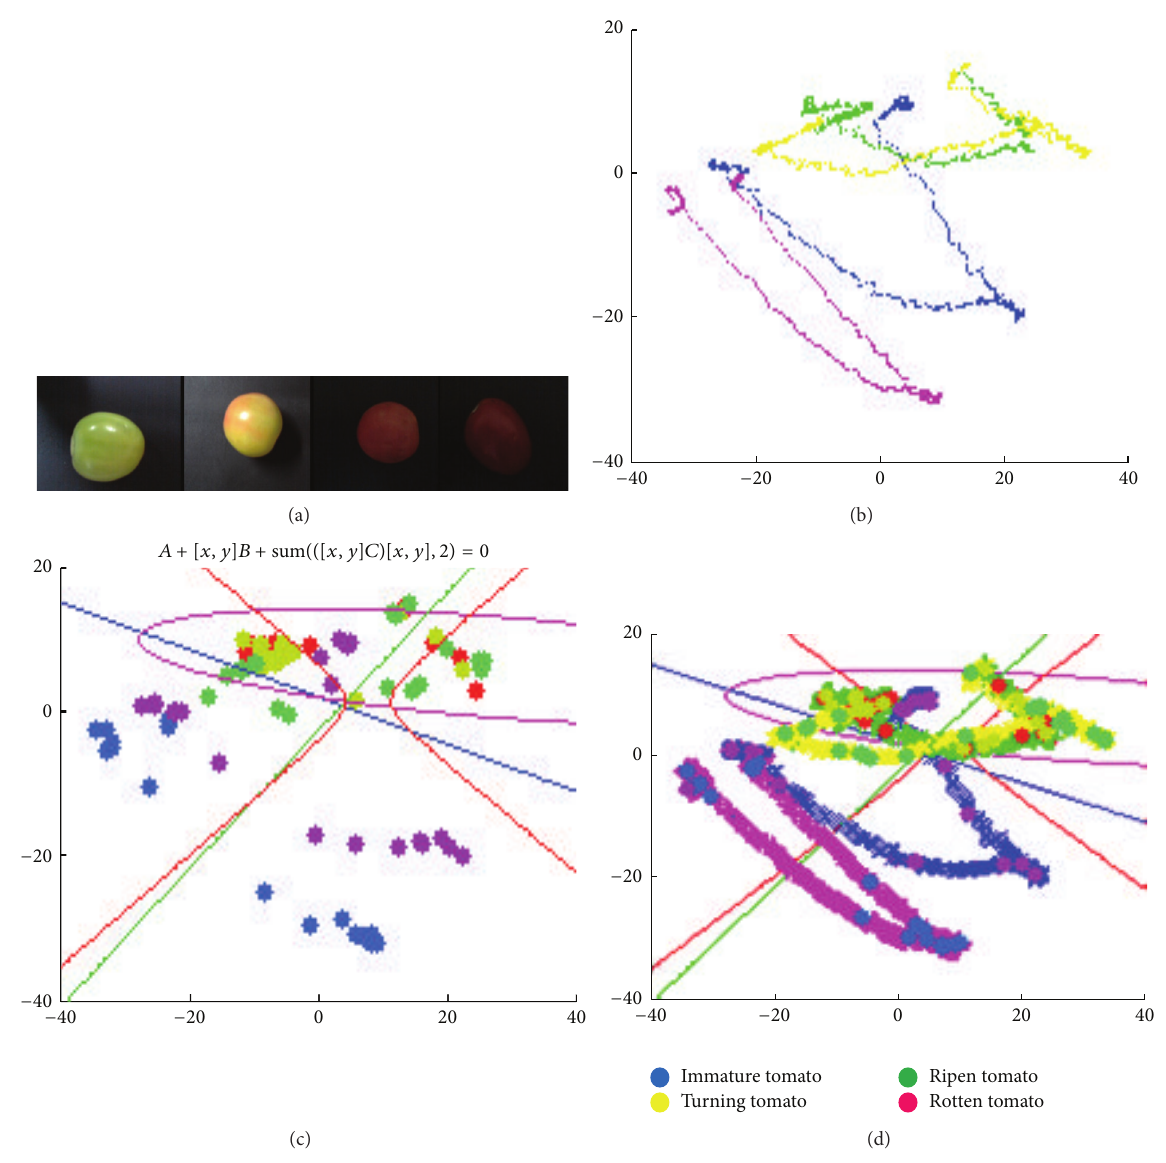
Figure 6: (a) Tomato sample used for experiments having different maturity levels, (b) principle component analysis (PCA), (c) linear discriminant analysis (LDA), and quadratic discriminant analysis (QDA), and (d) 𝑘 -nearest neighborhood